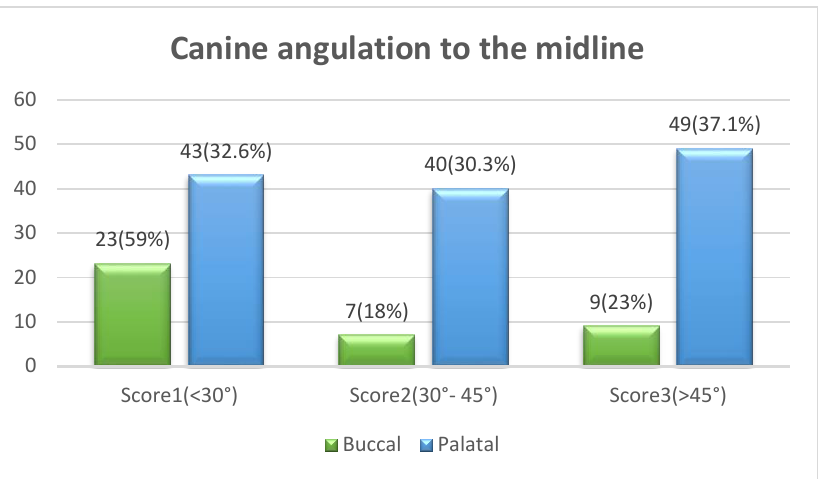
Figure 5. Comparison between buccal–palatal canine impaction and the canine angulation to the midline using the chi-square test (X 2 = 40.7, df = 3, p < 0.001 *). * Statistically significant at p ≤ 0.05.